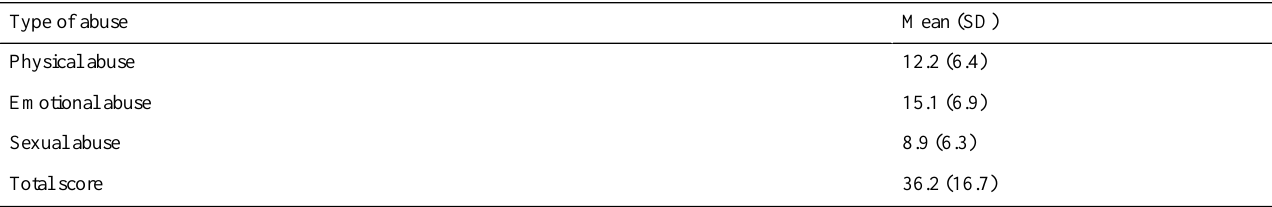
Table 1. Self-reported abuse history of an urban sample of unstably housed youth based on Childhood Trauma Questionnaire score. (Childhood Trauma Questionnaire scores indicating a clinically significant level of abuse are detailed in the assessment description